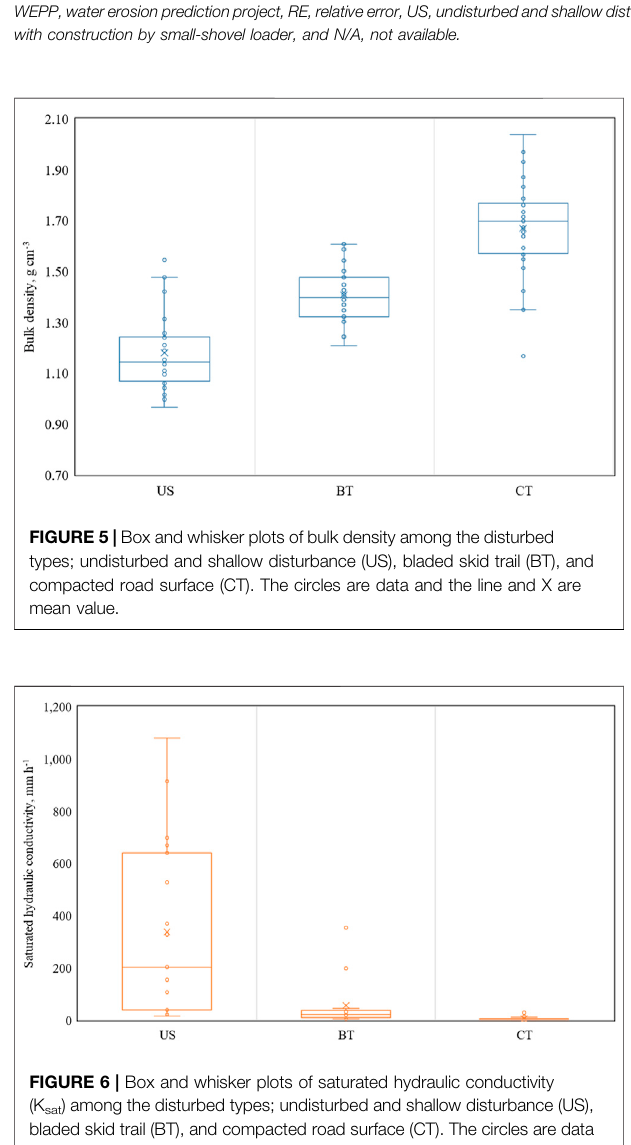
Frontiers in Environmental Science |